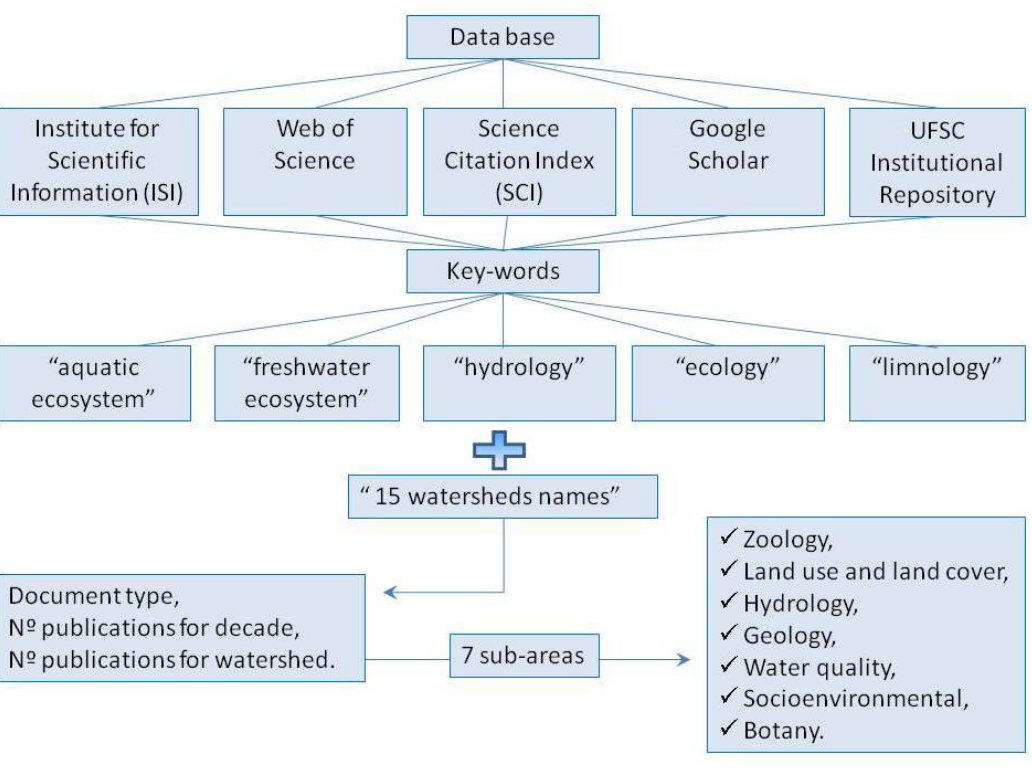
Figure 2. Workflow with filters used to evaluate the publications on aquatic systems in Santa Catarina Island (as suggested by